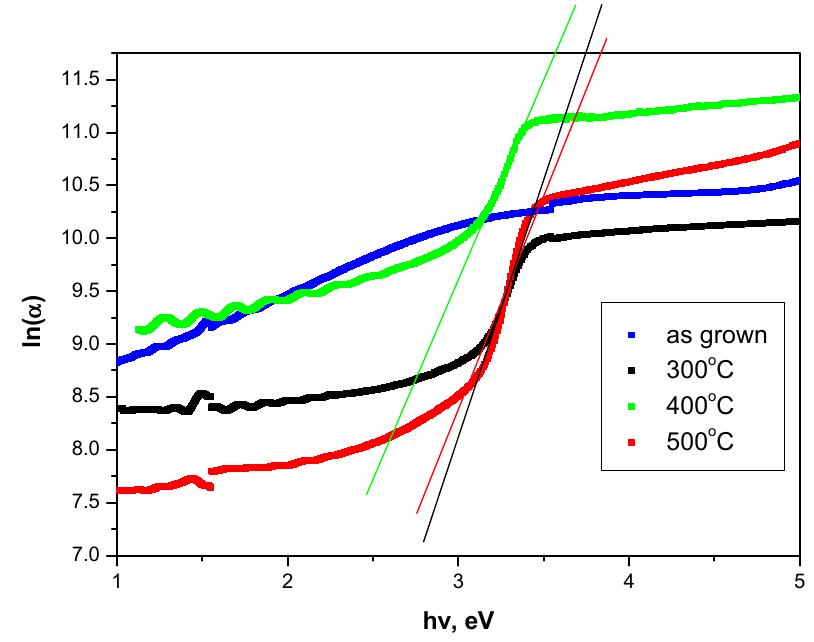
Figure 6. Calculations of Urbach energies for the ZnO:Co layer.